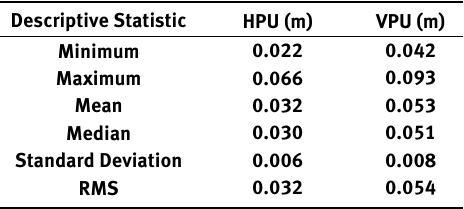
Table 5. Descriptive statistics for HPU and VPU, calculated based on CQ output scaled by a factor of 2.1 for 756 marks.